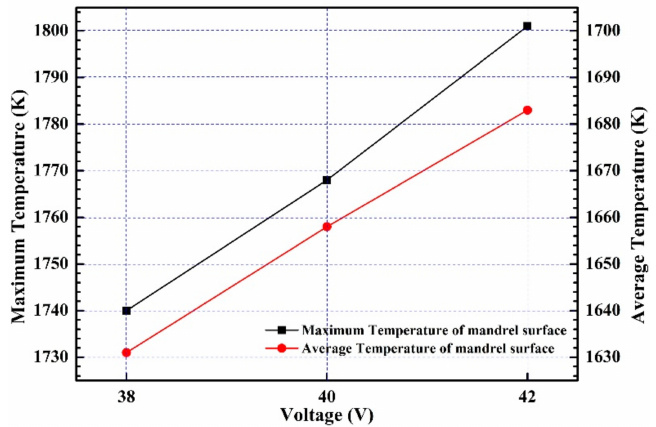
Figure 10. Evolution of the maximum and average temperature of the mandrel surface with different voltage at steady